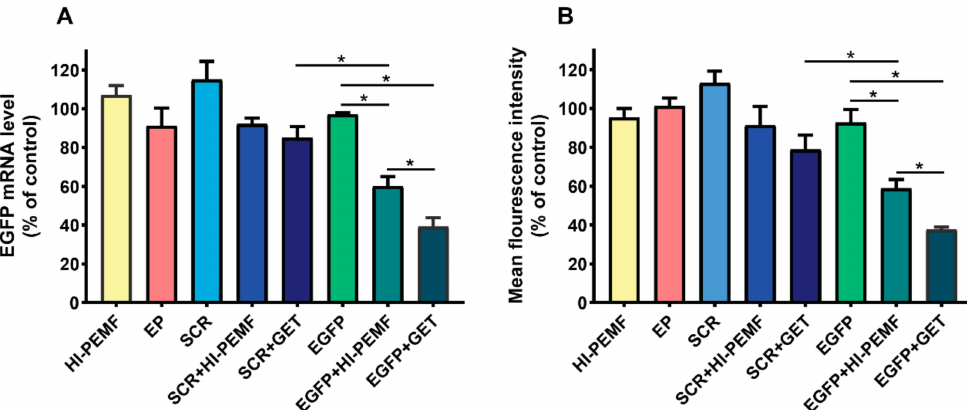
Figure 3. In vivo reduced expression of EGFP mRNA level and protein EGFP level after silencing in B16F10 tumors stably expressing EGFP. Tumors were treated with an intratumoral injection of either siMAX universal bu ff er (Control group, n = 6) or EGFP siRNA (EGFP group, n = 8) or SCR siRNA alone (SCR group-scramble, noncoding siRNA, n = 8), or with electrotransfer after electroporation by a high intensity pulsed electromagnetic field (HI-PEMF, n = 8) or conventional electroporation settings (EP, n = 6), as well as with a combination of siRNA electrotransfer by HI-PEMF ( n = 8) or conventional EP (GET, n = 8). ( A ) mRNA level of EGFP in B16F10 tumors stably expressing EGFP determined by qRT-PCR analysis. The data represent the mean and standard error of the mean. The mRNA levels of EGFP in tumors of all experimental groups were normalized to the mRNA level of the untreated group. ( B ) EGFP protein level in B16F10 tumors stably expressing EGFP determined by flow cytometry. The fluorescence intensity of EGFP in tumors of all experimental groups was